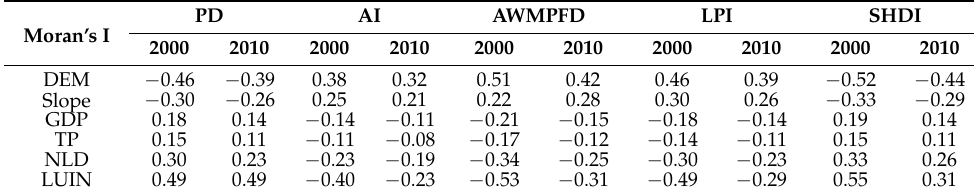
Table 4. Bivariate Moran’s I correlation analysis between landscape metrics and influencing factors in the spatial dimension in 2000 and